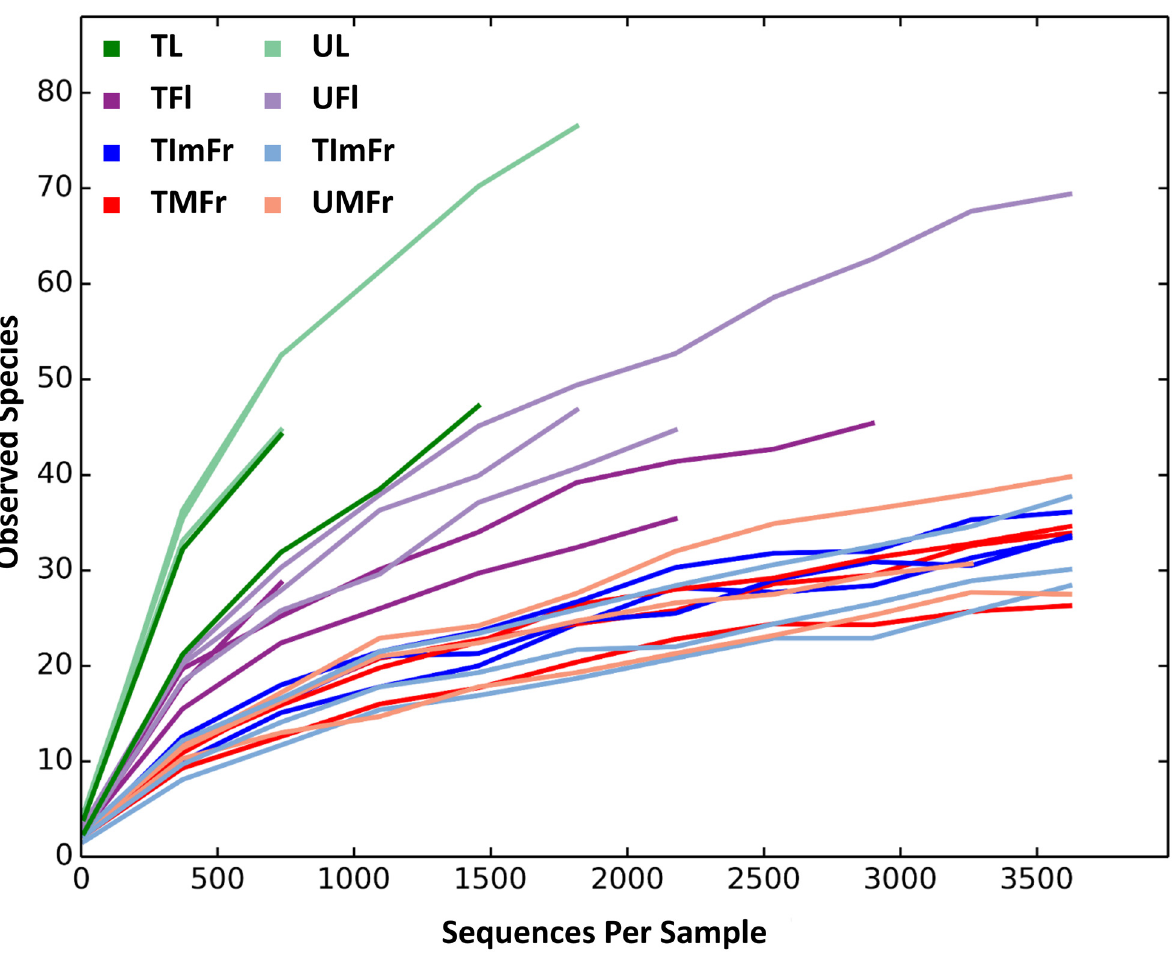
Fig 1. Rarefaction curves determined for all strawberry samples investigated in the present study. Investigated samples included treated (T) and untreated (U) flowers (TFl and UFl), immature fruit (TImFr and UImFr), leaves (TL and UL), and mature fruit (TMFr and